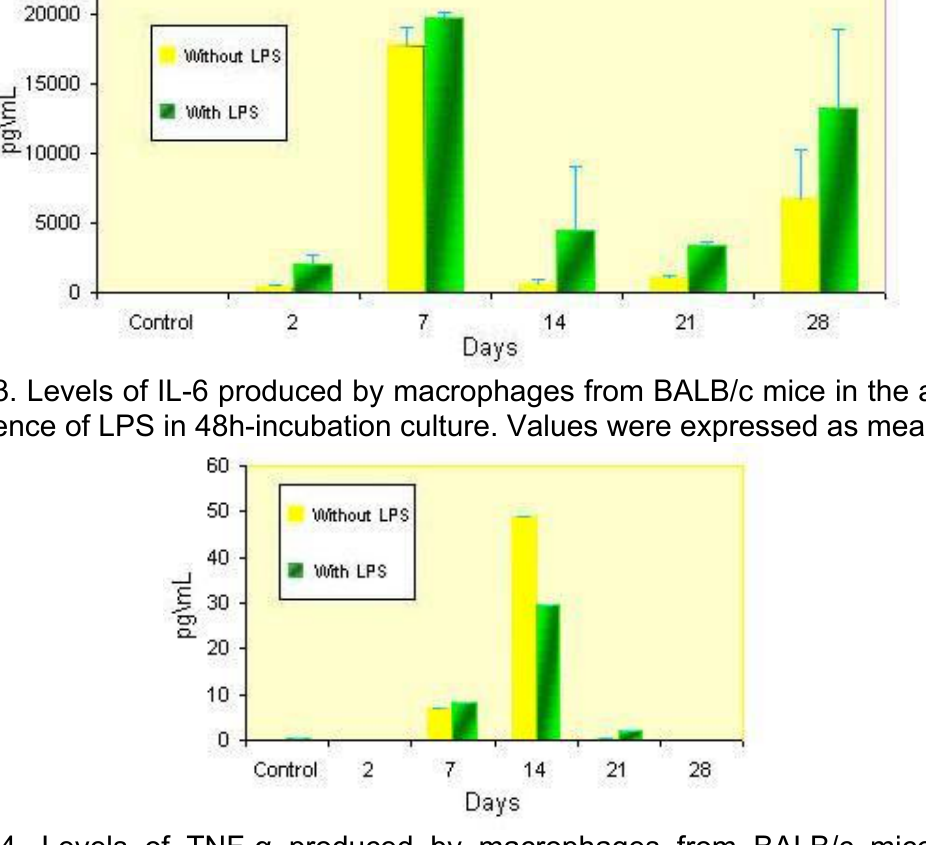
Figure 4. Levels of TNF- α produced by macrophages from BALB/c mice in the absence or presence of LPS in 24h-incubation culture. Values were expressed as means±SD.